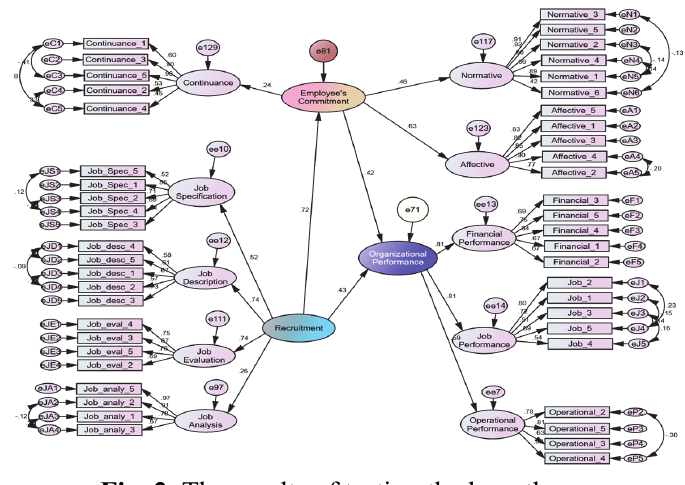
Fig. 2. The results of testing the hypotheses Standardized and unstandardized regressions (independent, mediator, and dependent variable) Hypothesis Latent variables independent, mediator, dependent Standardized Unstandardized Sig. Estimates Estimates R H1 Recruitment process → Organizational performance Recruitment process → Employee commitment Employee commitment → Organizational performance